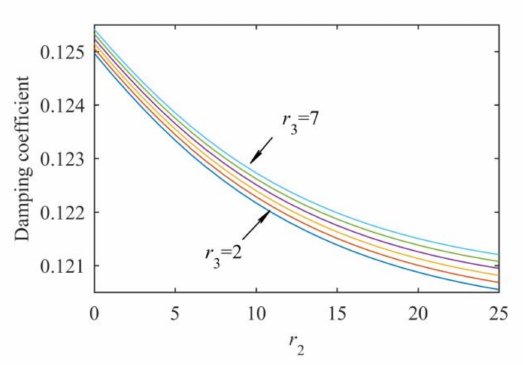
Figure 8. Relationship between r and the damping coefficient.